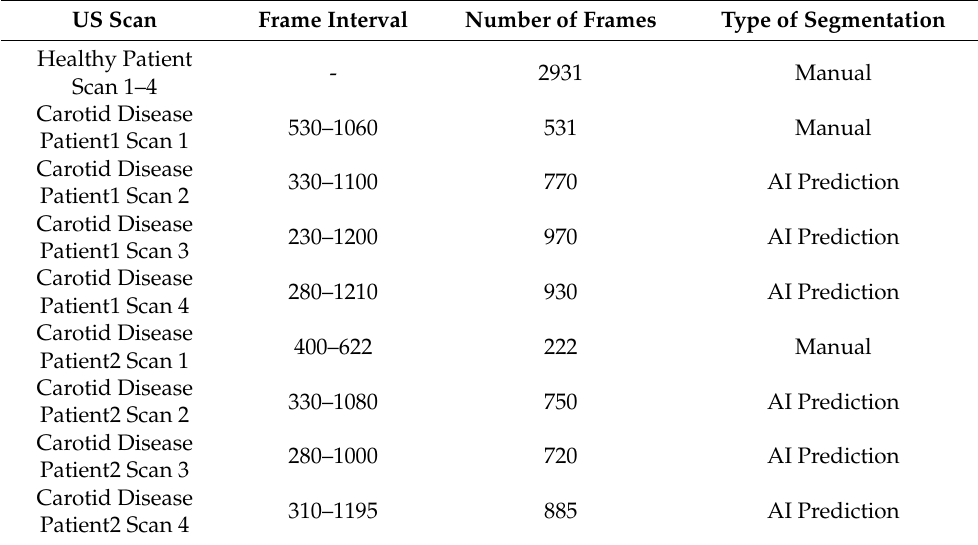
Table 2. The frames selected from the acquired US data for the carotid-artery-disease